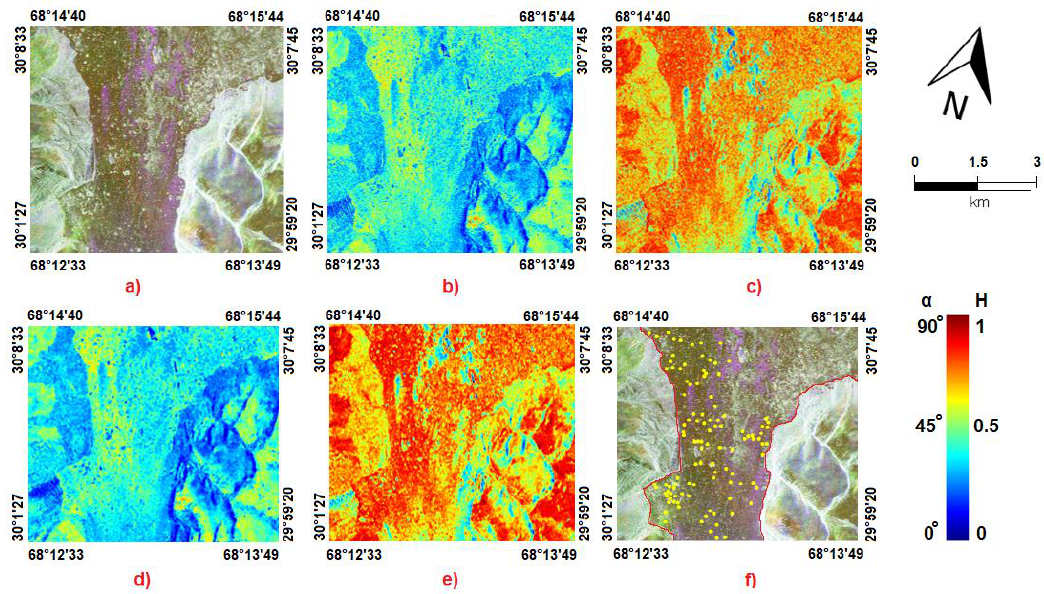
Figure 4. Output close-up images for Blosseville Coast N, 15 / 08 / 2015 01:26, ( a ) Pauli RGB image, ( b ) alpha image in a 5 × 5 window, ( c ) entropy image in a 5 × 5 window, ( d ) alpha image in an 11 × 11 window, ( e ) entropy image in an 11 × 11 window, ( f ) visual analysis of icebergs (in yellow) and coastline (in red). Numbers on the edges of images indicate image DMS coordinates. The sea ice situation is a mix of ice floes and open